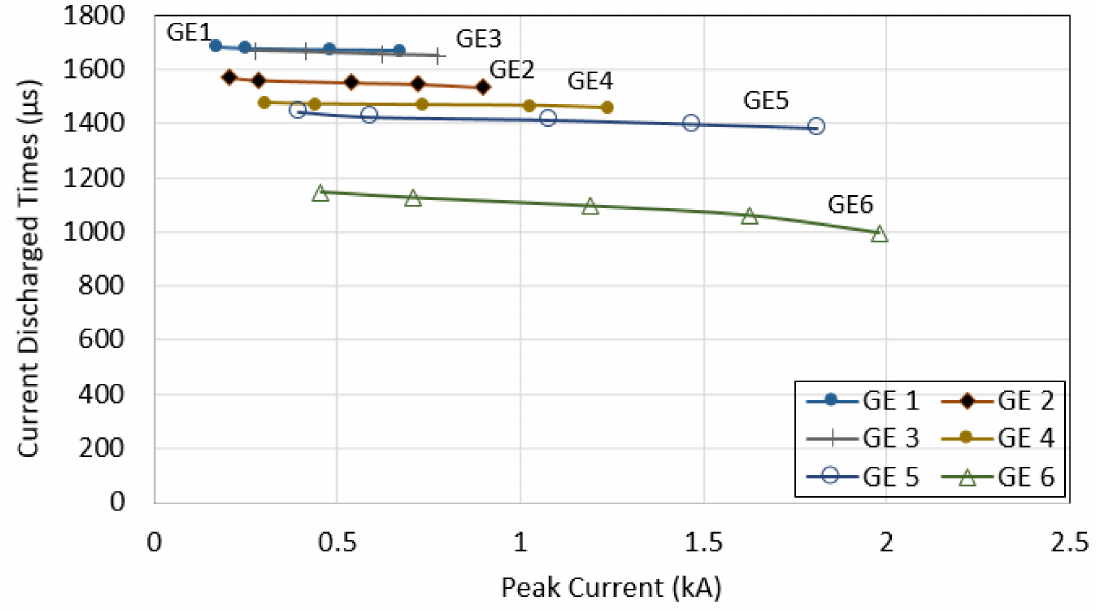
Figure 7. Current discharged times for GEs at various peak current magnitudes under negative impulse